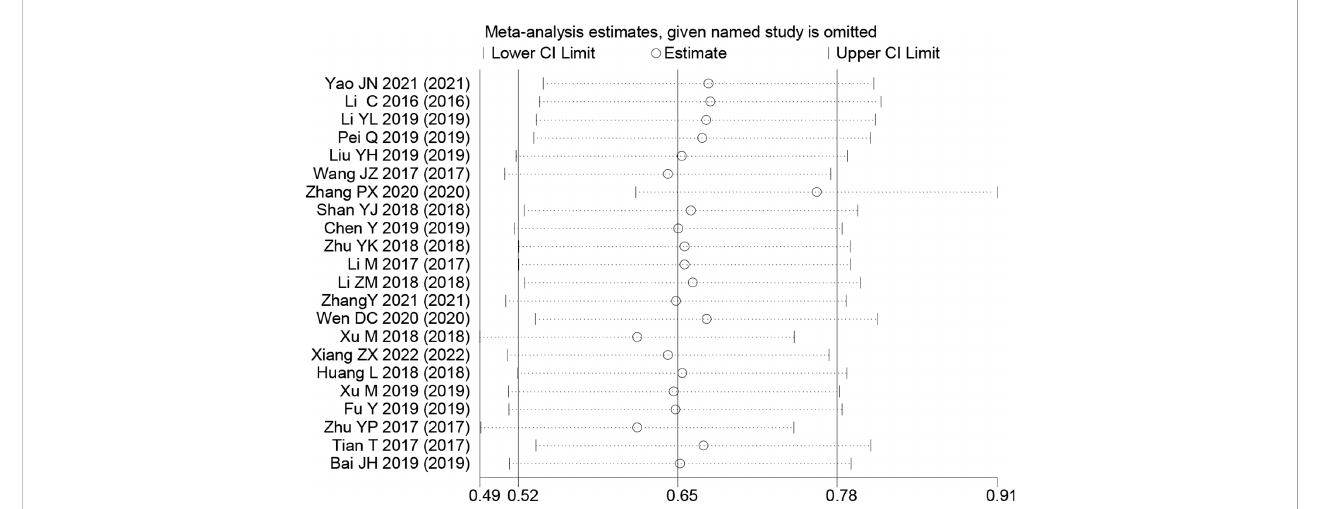
FIGURE 8 Sensitivity analysis for small nucleolar RNA host gene expression with overall survival in colorectal cancers. HR, hazard ratio; CI, con fi dence interval.